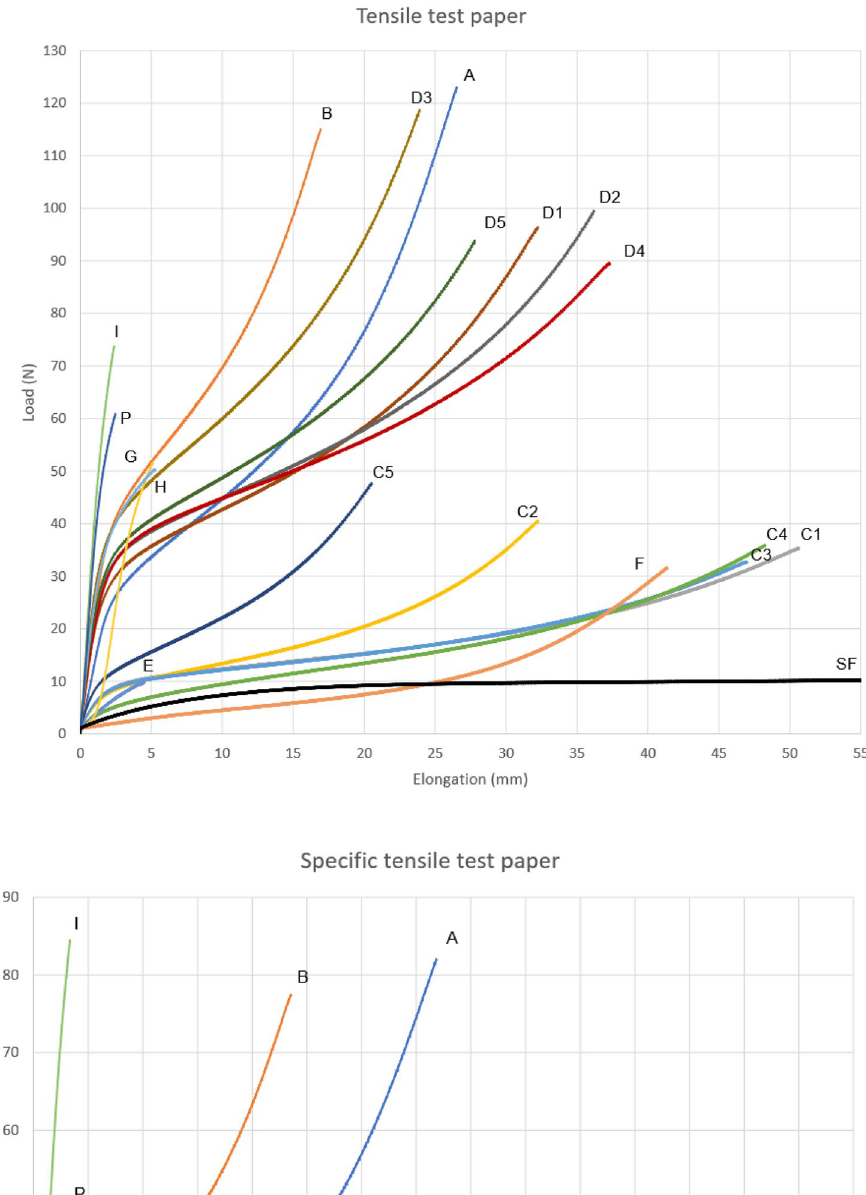
Fig. 6 Averaged results of tensile tests